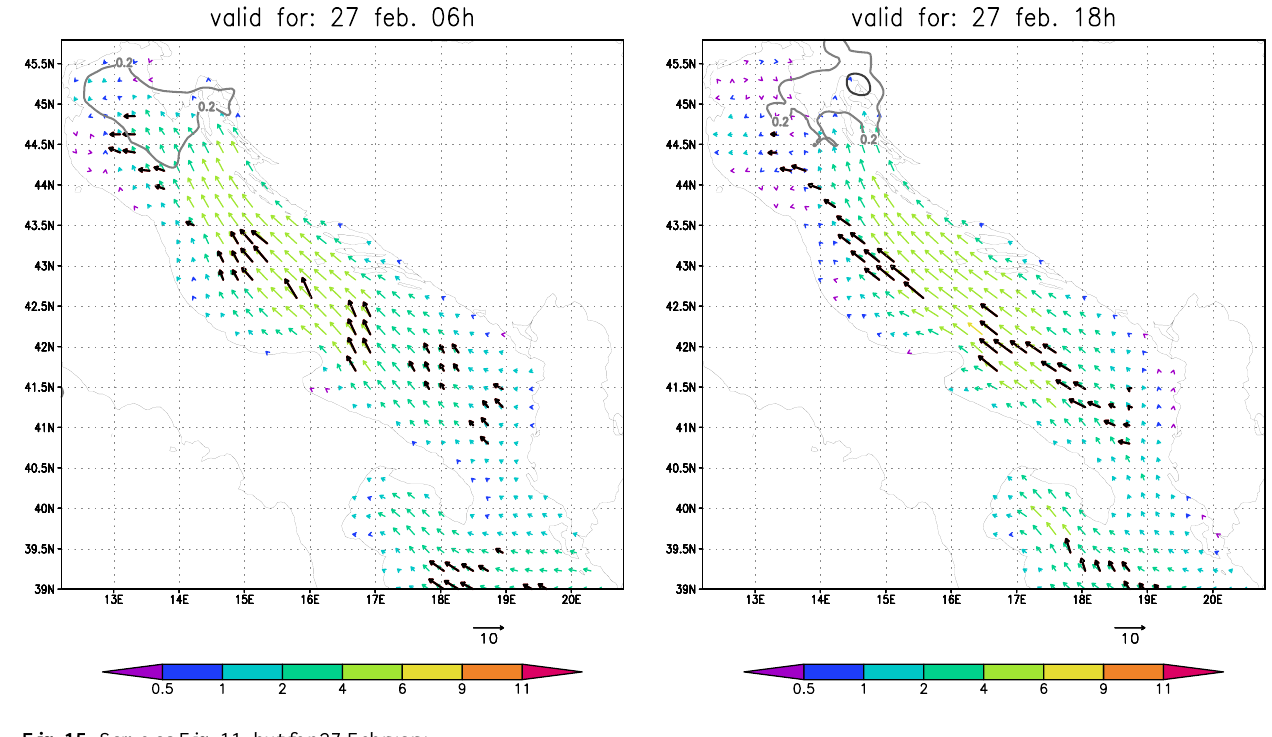
Fig. 15. Same as Fig. 11, but for 27